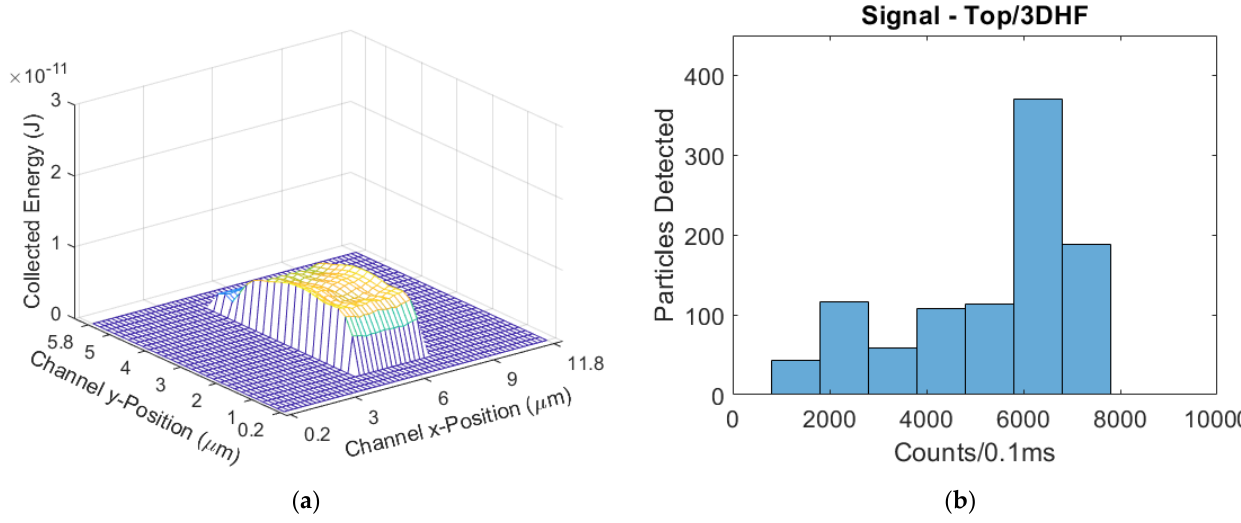
Figure 14. ( a ) The modeled excitation region for the top-illuminated biosensor with a 3DHF flow regime; ( b ) The simulated signal distribution, with the furthest-right skew of all devices in the side-illumination format.